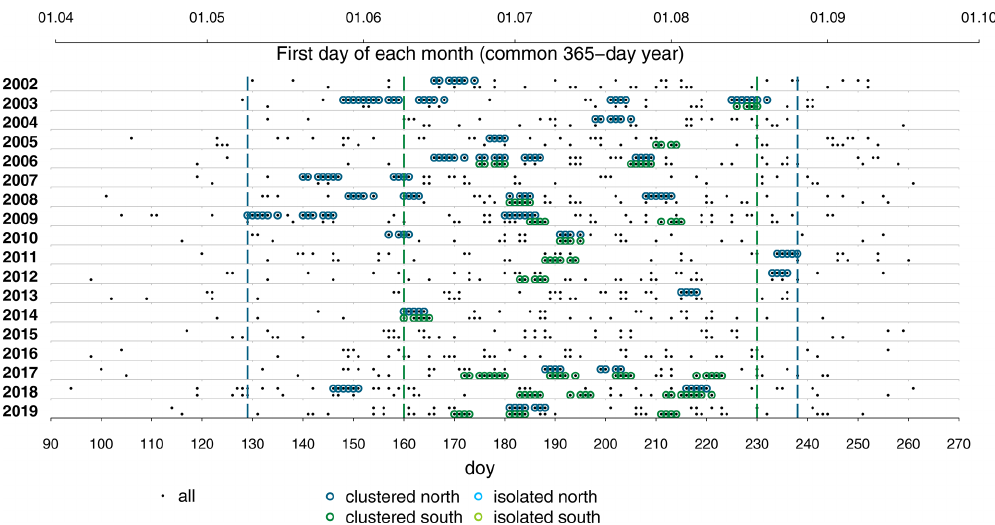
Figure 2. All hail days for each year between 2002 and 2019, north of the Alps (top rows, blue colors) and south of the Alps (bottom rows, green colors); the clustered hail days have dark circles, and the isolated hail days have light colored circles. Note that isolated hail days are only considered in the analysis if they occur no earlier or later in the year than the earliest or latest clustered hail day (marked by vertical dashed lines). The top x axis indicates the first day of each month for common years. For leap years, the axis needs to be displaced by 1d to the right. Table 1. Number of hail days north and south of the Alps and the number of days leading to them. The bold columns indicate how many days enter the composites of the large-scale flow. Total number Clustered events Isolated events of hail days clustered days before clustered isolated days before isolated hail days hail days clustered hail hail days in hail days isolated hail in the DOY range days ( d − 1 , independent days ( d − 1 , of clustered d − 2 , d − 3) 5d periods d − 2 , d − 3) hail days North of the Alps 476 164 31 135 96 69 69 South of the Alps 444 102 21 89 99 42